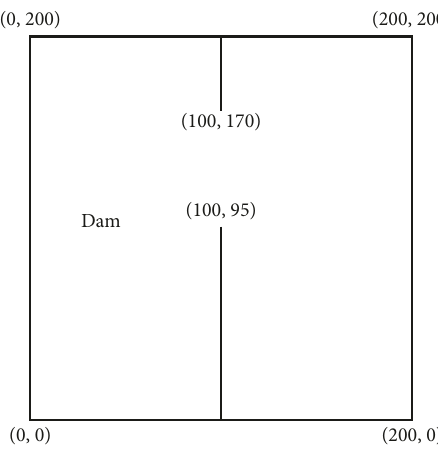
Figure 5: Top view of partial dam-break domain.